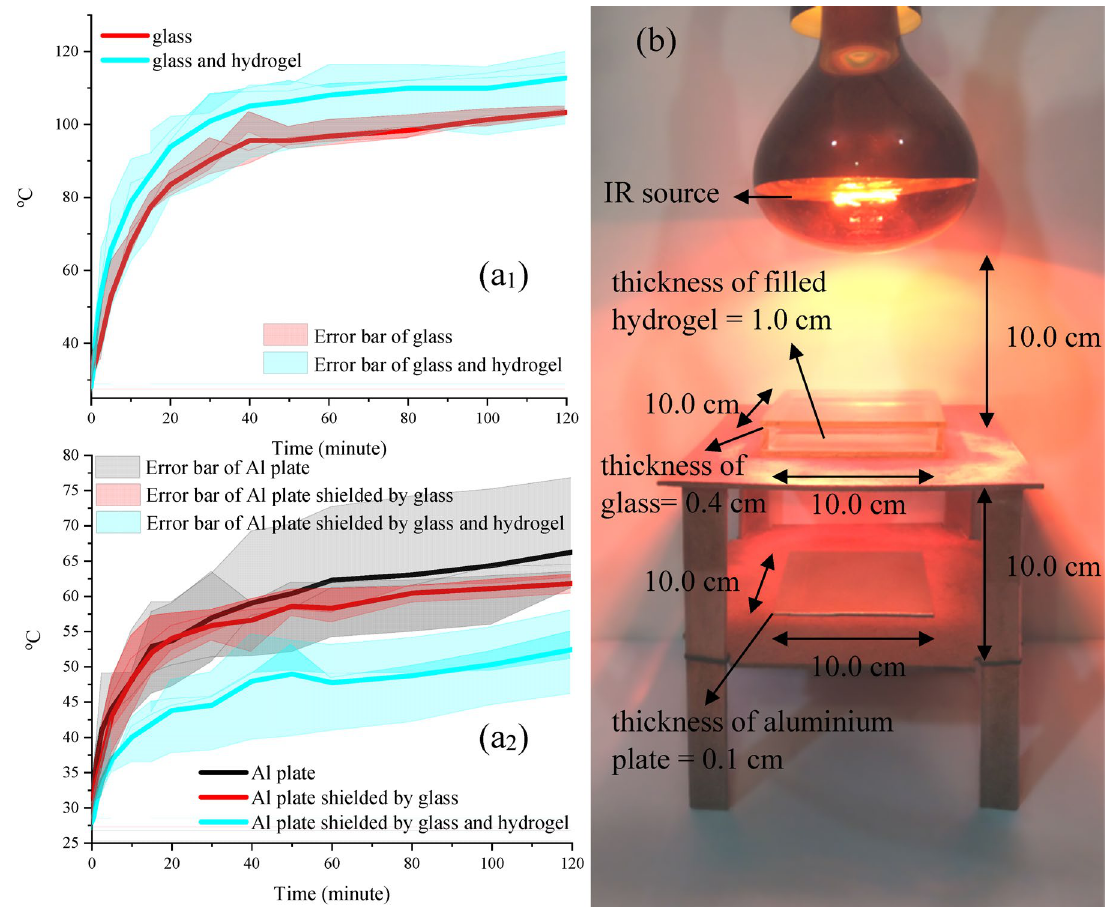
Figure 6. IR light absorption ( a 1 , 2 ) and optothermal setup ( b